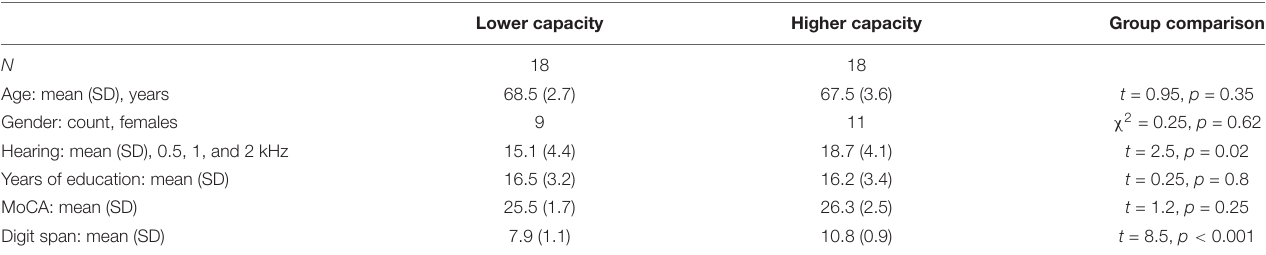
TABLE 2 | Background information by working memory capacity